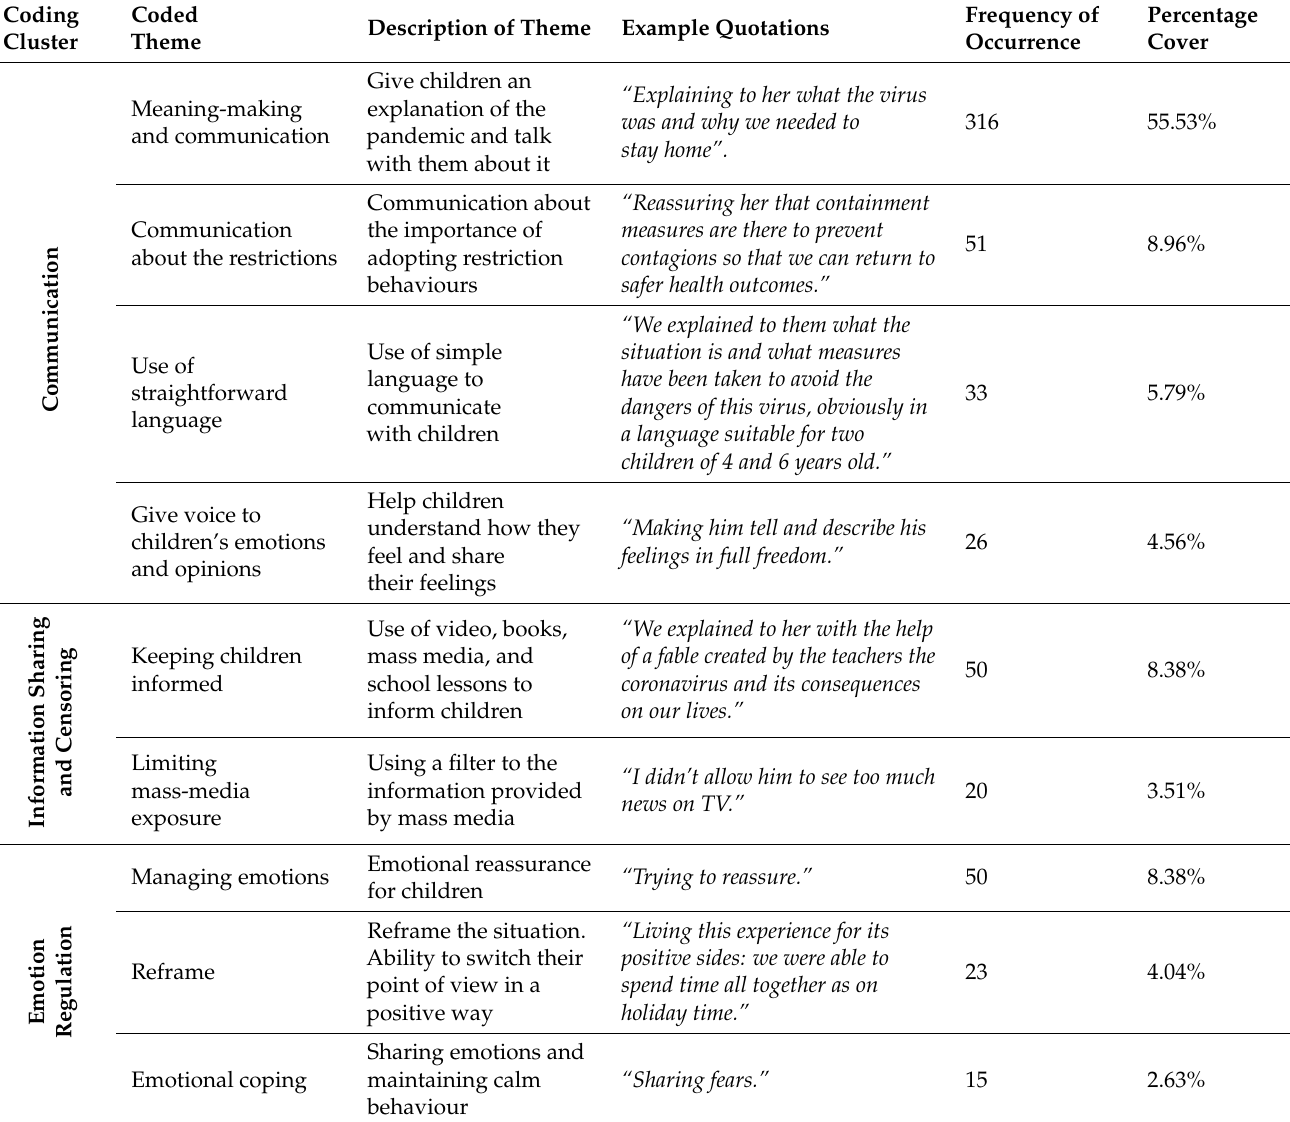
Table 2. Clusters and coded themes identified from the qualitative analysis provided examples of statements and